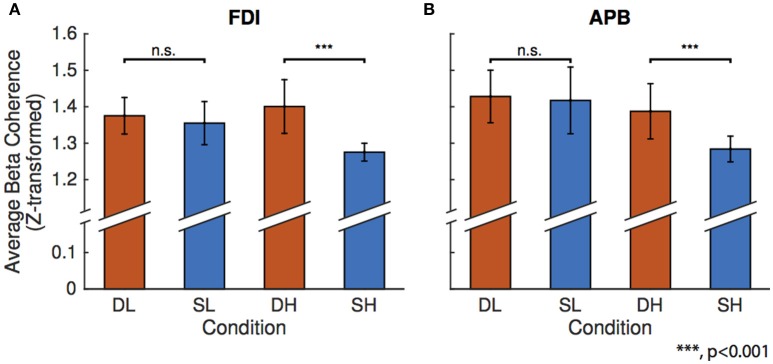
Results of the linear mixed-effects model for the four conditions: dowel-low (DL), spring-low (SL), dowel-high (DH), and spring-high (SH). The model was constructed to predict mean beta range coherence using condition as the fixed-effect with corrections for the random effects of participant. In each bar graph, the mean beta range CMC is shown on the vertical axis and condition is on the horizontal axis. Bars representing one standard error are shown for each condition and significance above the matched force level column pairs represent the statistical difference in the linear mixed-effect coefficients as determined using an F-test. (A) Linear mixed-effect found no differences in FDI-EEG beta coherence for the low forces, but found a significant difference between the higher force compression conditions. (B) Linear mixed-effect model results for APB-EEG coherence show the same statistical results for low and high conditions as in FDI-EEG.